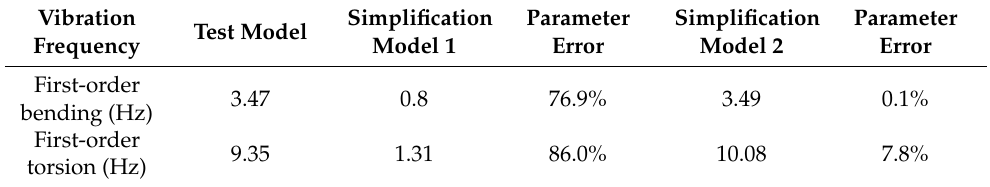
Table 7. Errors in the vibration frequency of the simplified model and the experimental